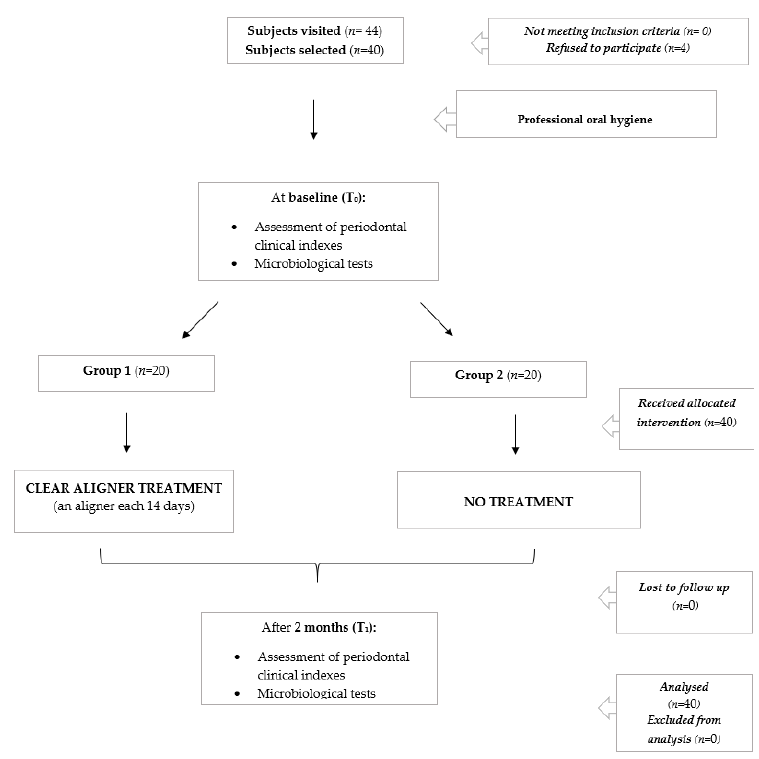
Figure 1. Flow chart of the